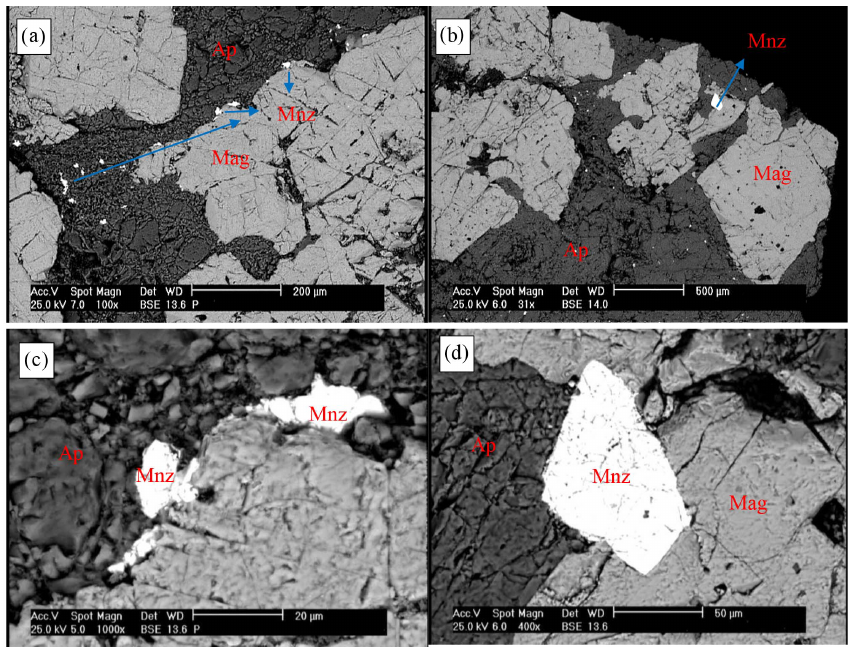
Figure 2. Back-scattered electron images of a sample from phosphate rocks. Abbreviations: Ap – apatite; Mnz – monazite; and Mag –